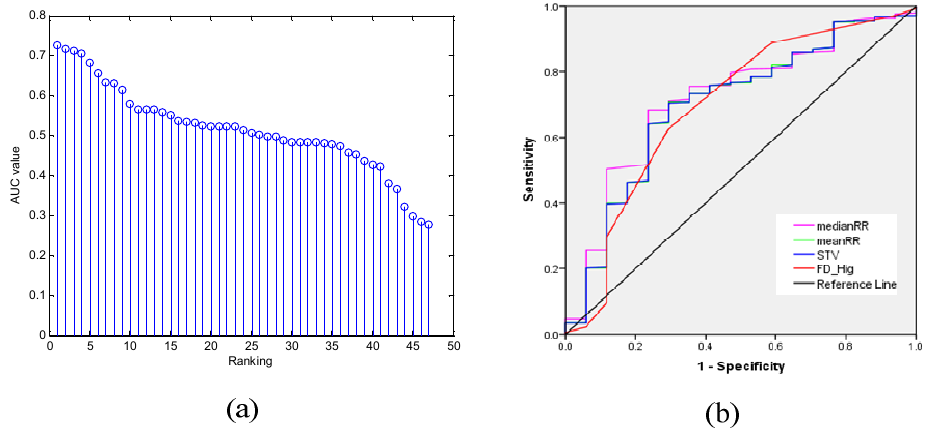
Figure 5. The result of feature selection using area under the curve (AUC). ( a ) The AUC value of a total of 47 individual features for classifying the fetal state in descending order; ( b ) The receiver operating characteristic (ROC) curve for the top four features used in the diagnosis of a pathological situation: MedianRR, AUC = 0.73 (95% CI, 0.62–0.86), p = 0.001; meanRR, AUC = 0.72 (95% CI, 0.60–0.84), p = 0.003; STV, AUC = 0.71 (95% CI, 0.60–0.83), p = 0.003; FD_Hig, AUC = 0.71 (95% CI, 0.59–0.83), p = 0.005.